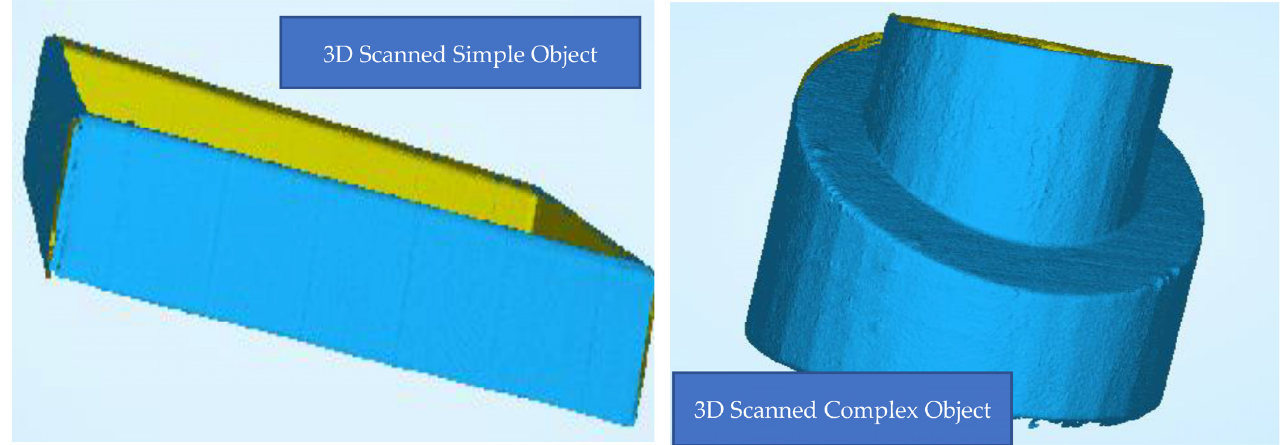
Figure 3. Three ‐ dimensional scanned sample geometries with texture scan option.